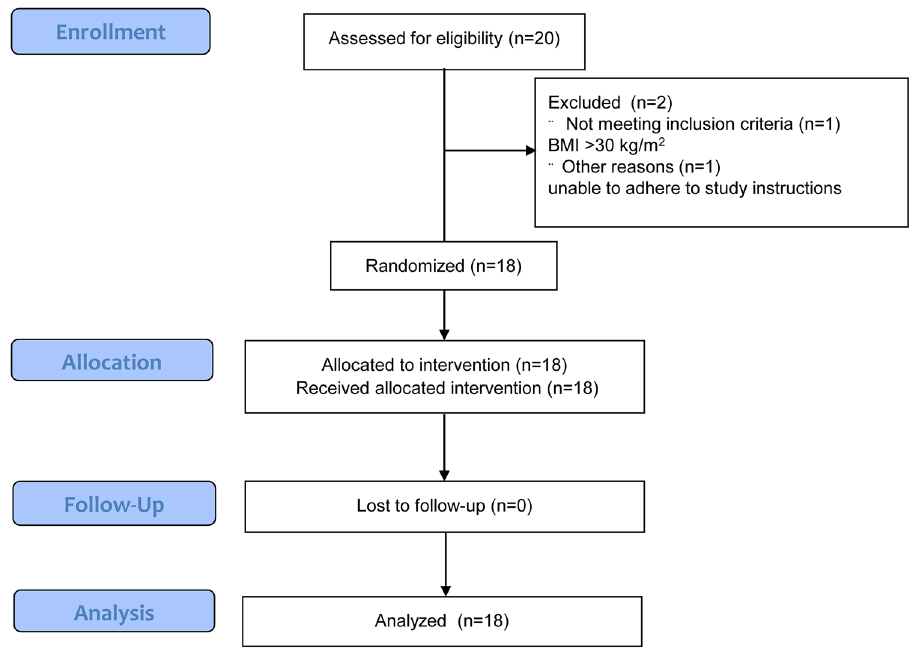
Figure 1. Flowchart of inclusion of